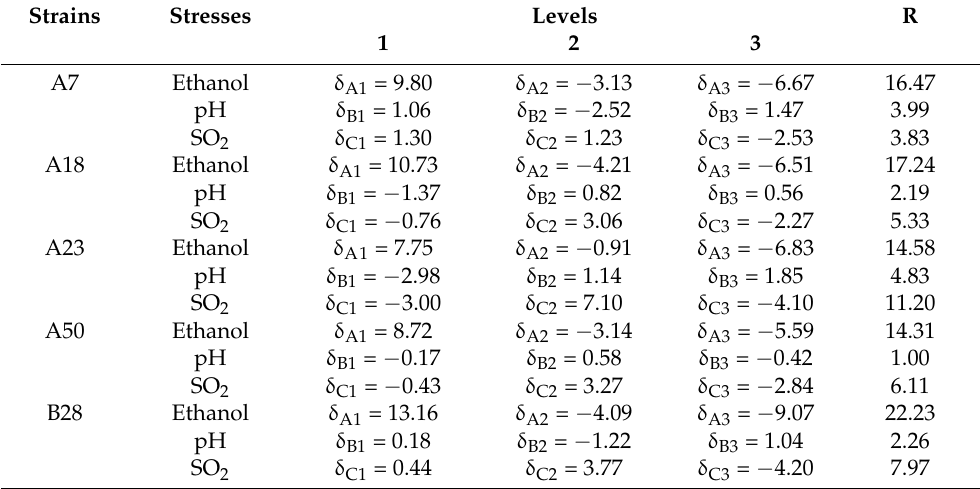
Table 4. The orthogonal experiment results.